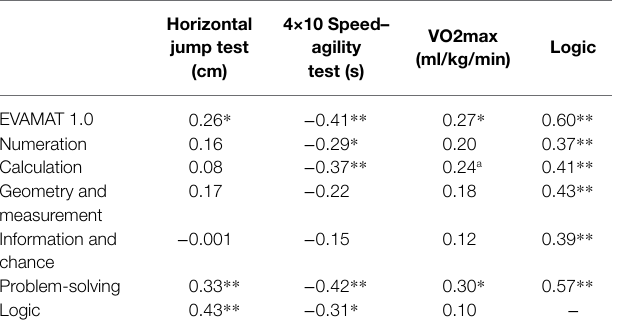
TABLE 2 | Correlations between the variables of logical–mathematical performance and physical